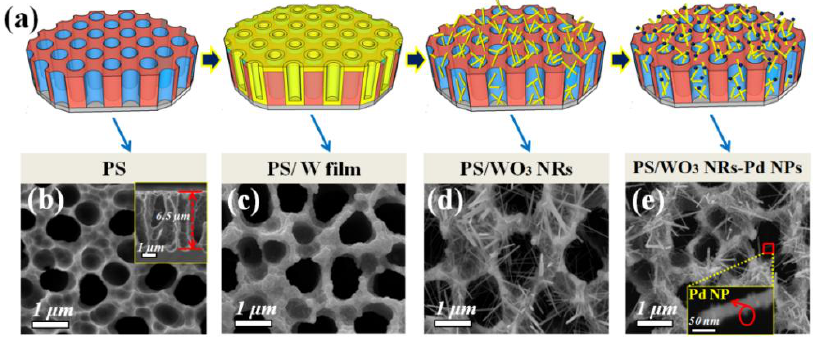
Figure 2. ( a ) Schematic illustration of the fabrication process of porous silicon(PS)/WO 3 nanorods (NRs)–Pd nanoparticles (NPs); SEM images: top view of ( b ) PS (inset: cross-section view); ( c ) PS/W film; ( d ) PS/WO 3 NRs; and ( e ) PS/WO 3 NRs–Pd NPs (inset: magnification).